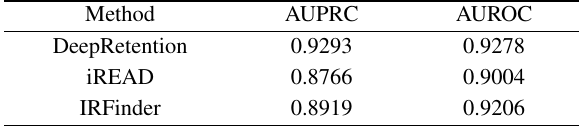
Table 3 Comparison results of iREAD, IRFinder, and DeepRetention on the simulated test dataset